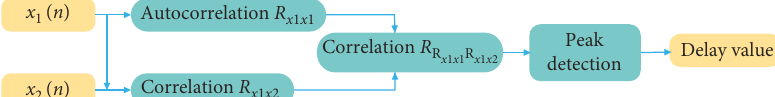
Figure 14: The principle block diagram of quadratic correlation delay estimation.